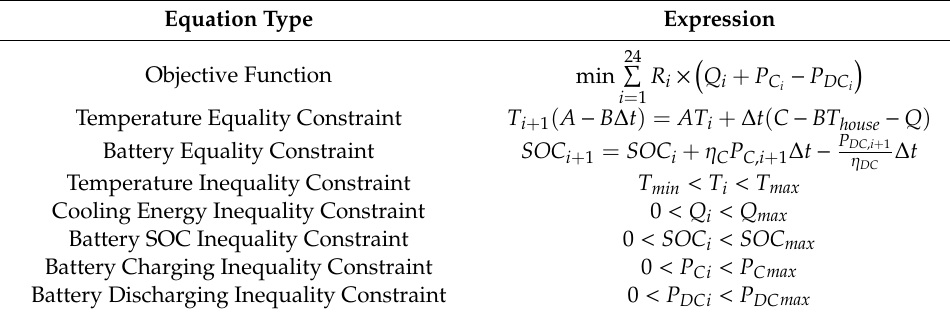
Table 1. Cost optimization